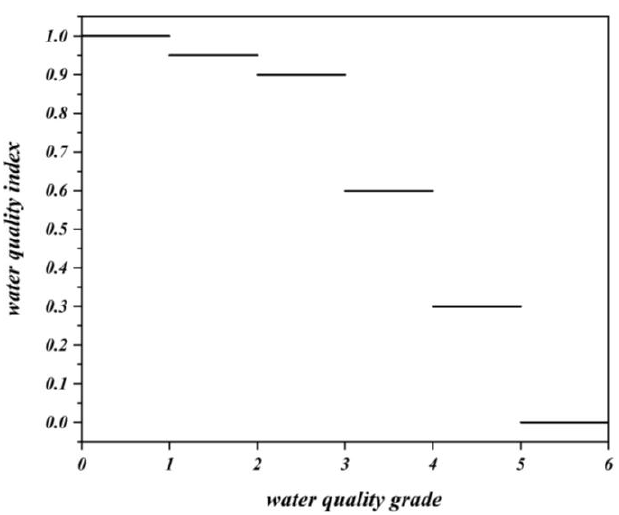
Figure 1. Relationship between water quality grade and water quality coefficient.